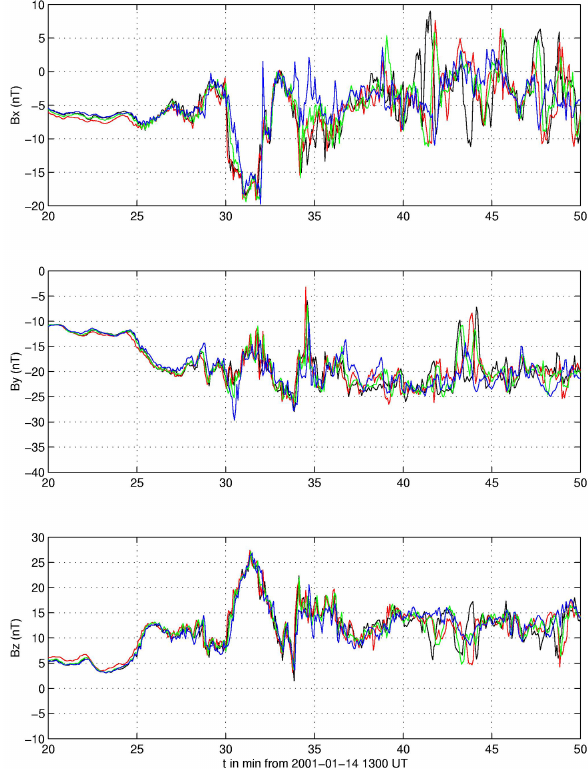
Fig. 19. Three component magnetic field data in GSE-coordinates from 13:20 to 13:50 UT from the Cluster FGM experiments on all 4spacecraft. The color-coding is again standard Cluster, but here using blue instead of magenta for